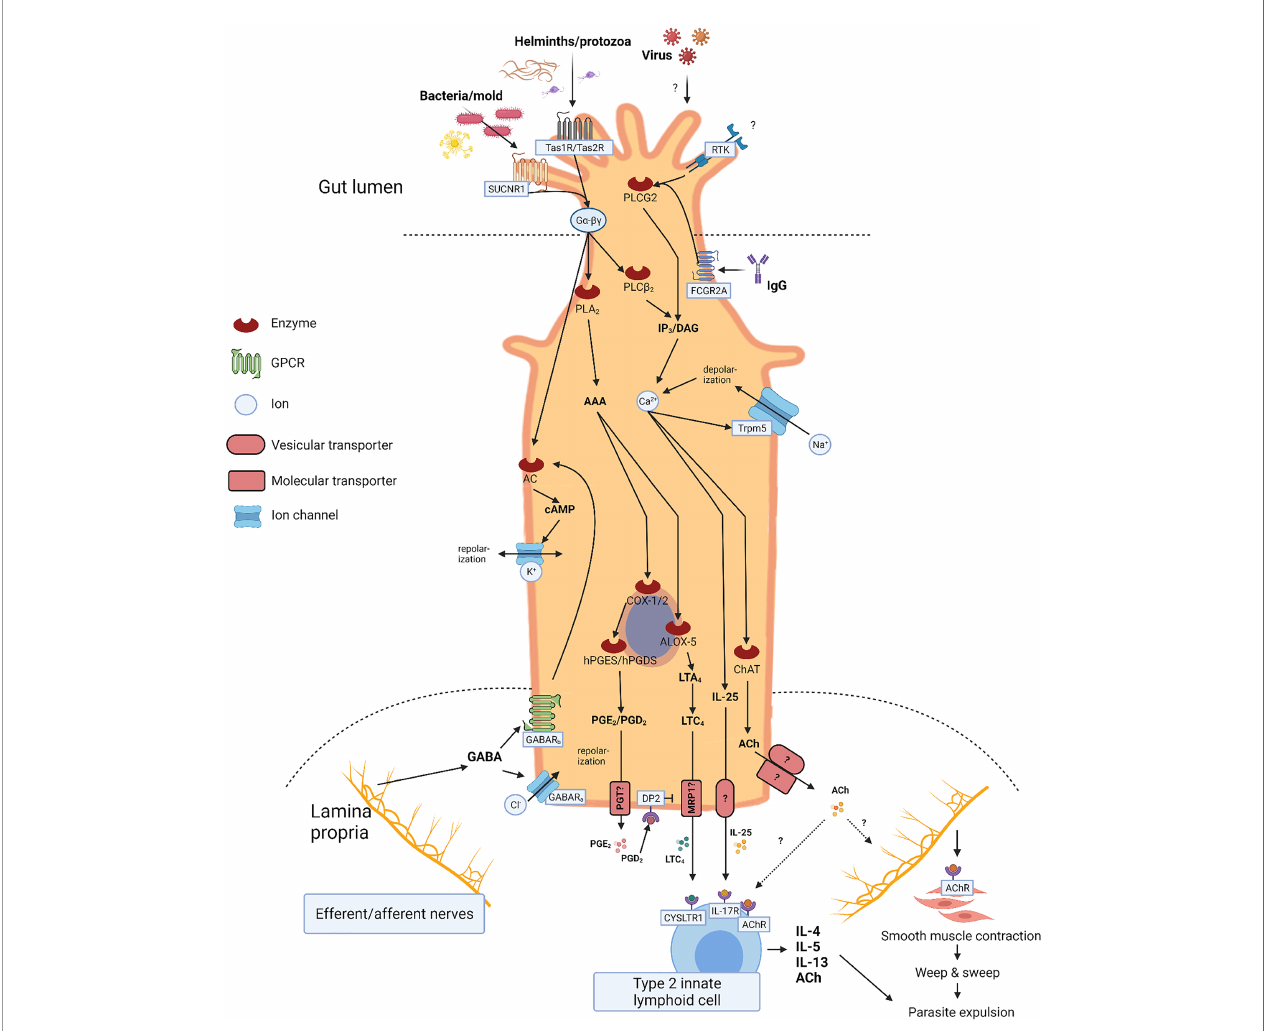
FIGURE 2 | Tuft cell (TC) signaling. Illustration of TC signaling including input, output, and second messengers. Apical signaling involves luminal G-protein coupled receptors including succinate receptor 1 (SUCNR1), taste receptors (Tas1R/Tas2R), and receptor tyrosine kinases (RTK). Cell depolarization and IP3/DAG activity leads to increased intracellular calcium levels stimulating intracellular synthesis of effector molecules such as interleukin (IL)-25, acethylcholine (ACh), and eicosanoids. Activated arachidonic acid (AAA) is metabolized by cyclooxygenase enzyme (COX)-1/2, hematopoietic prostaglandin D synthase (hPGDS), and arachidonate 5- lipoxygenase (ALOX5) into prostaglandin E 2 (PGE 2 ), prostaglandin D 2 (PGD 2 ), and cysteinyl leukotriene C 4 (LTC 4 ), respectively. Basolateral secretion of IL-25 and ACh occurs through yet unknown mechanisms, whereas secretion of PGE 2 and PGD 2 is facilitated through the prostaglandin transporter (PGT), and LTC 4 possibly through the multidrug resistance protein 1 (MRP1). Basolateral signaling involves GABAA (ligand-gated chloride channel) and GABAB (G-protein coupled) receptors. Stimulation initiates cell repolarization mediated by GABA